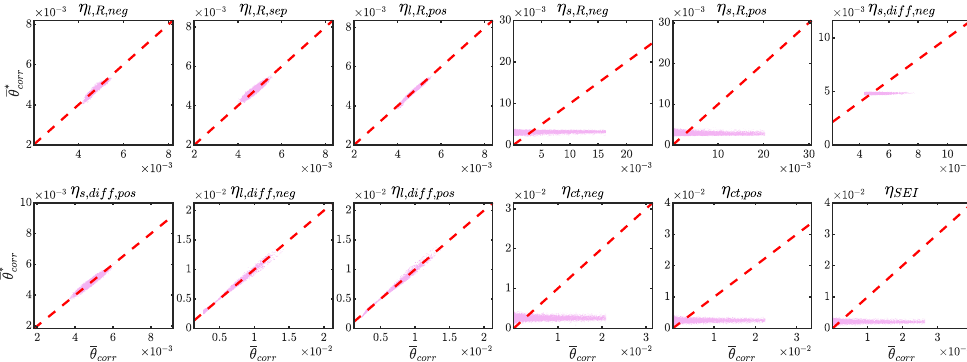
Figure 6. Results of parameter correlation for case 2. Similar to the results of case 1, it can be observed that all processes except the conduction in the solid phase, the solid diffusion in the anode, and the interfacial processes are correlated with each other in different parameter